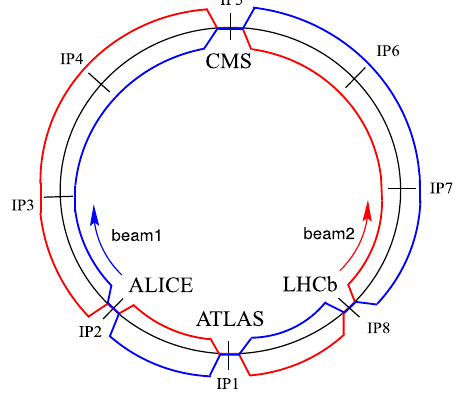
FIG. 1. Schematic layout of the IPs of the LHC.